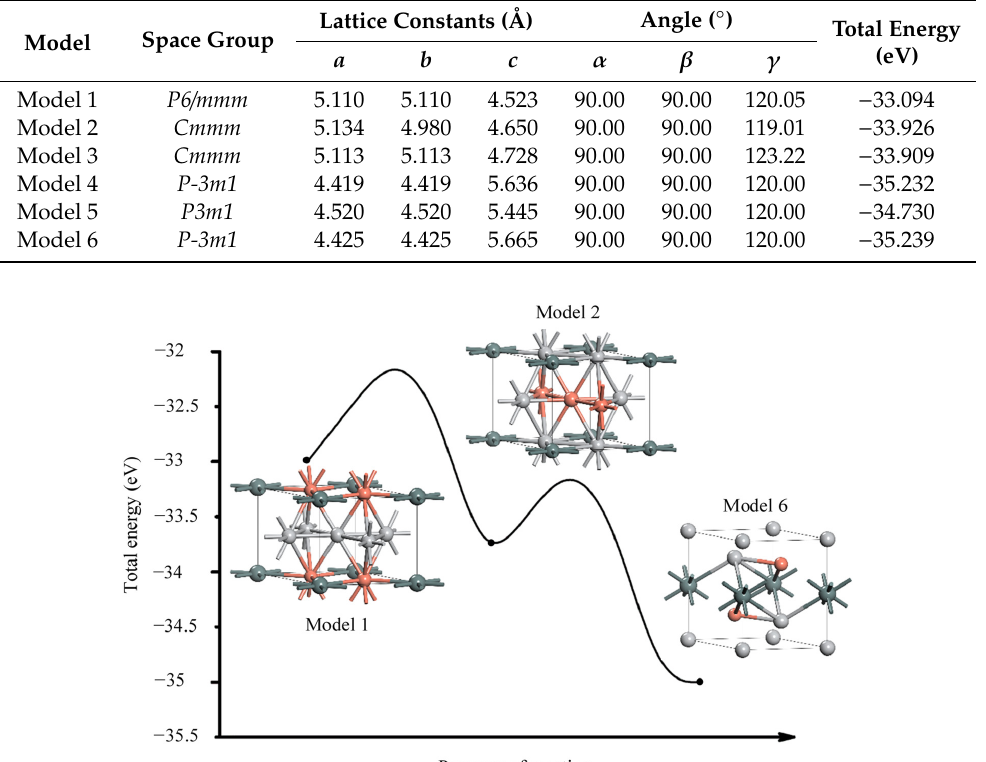
Figure 4. Energy profile of Models 1, 2, and 6. Red, gray, and dark green spheres represent the atoms Cu, Ti, and Sn, respectively.